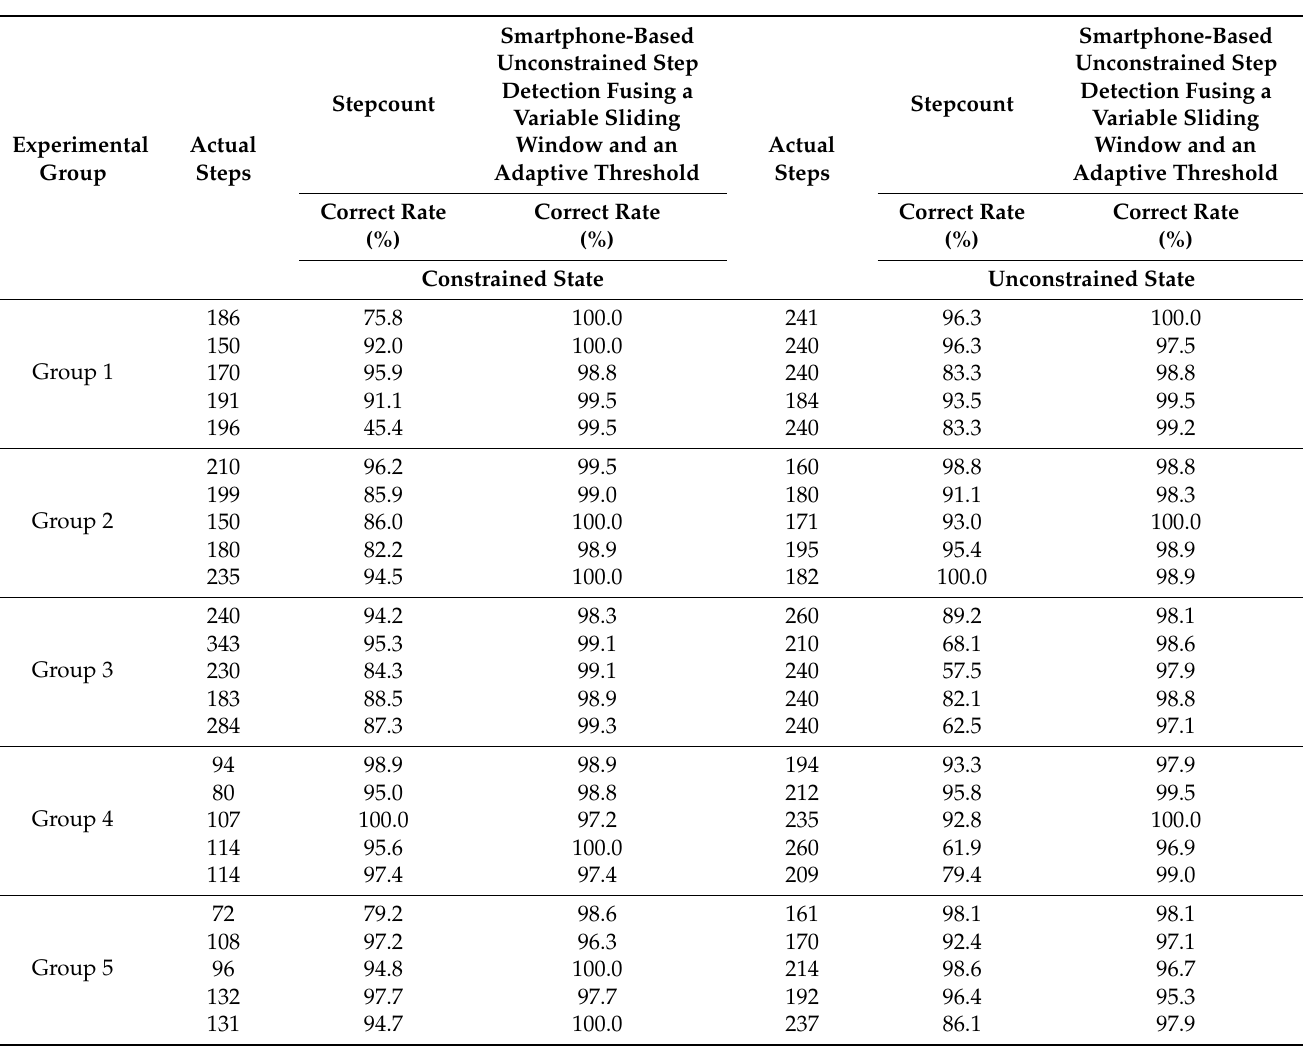
Table 5. Constrained state and unconstrained state step counting result.